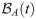
Clout versus budget and activists.The time evolution of the fractions of persuadable voters a0(t), b0(t), activists a+(t), b+(t), empty nodes o(t) as well as the budgets BA(t) and BB(t). The shown curves are the results of a stochastic simulation on a random regular network with N = 105 nodes, k = 10 and the following initial conditions: a0(0) = 0.32, b0(0) = 0.205, a+(0) = 0.175, b+(0) = 0.1 and o(0) = 0.2. The cost is set to cA = cB = 0.3. The grey curves are the numerical mean-field solutions of Eq (2). The left panel shows the situation where both campaign groups have activists with ρA = ρB = 0.1. In the right panel, the convincing probability in campaign group B has been increased to a value of ρB = 0.18, leading to a change of the majority structure.